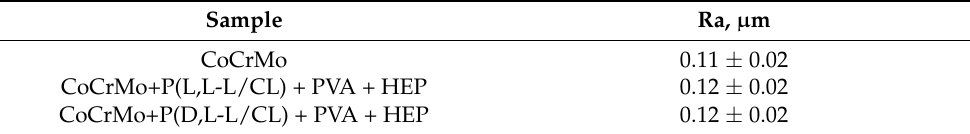
Table 1. Results of roughness measurements.